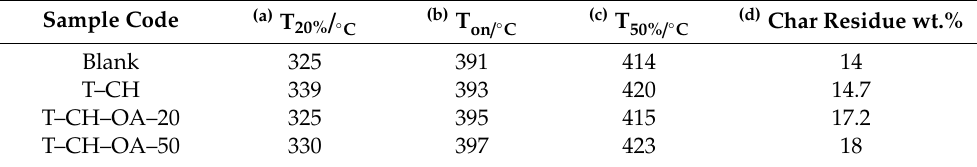
Table 2. Thermal characteristic and flammability data for uncoated and coated samples.